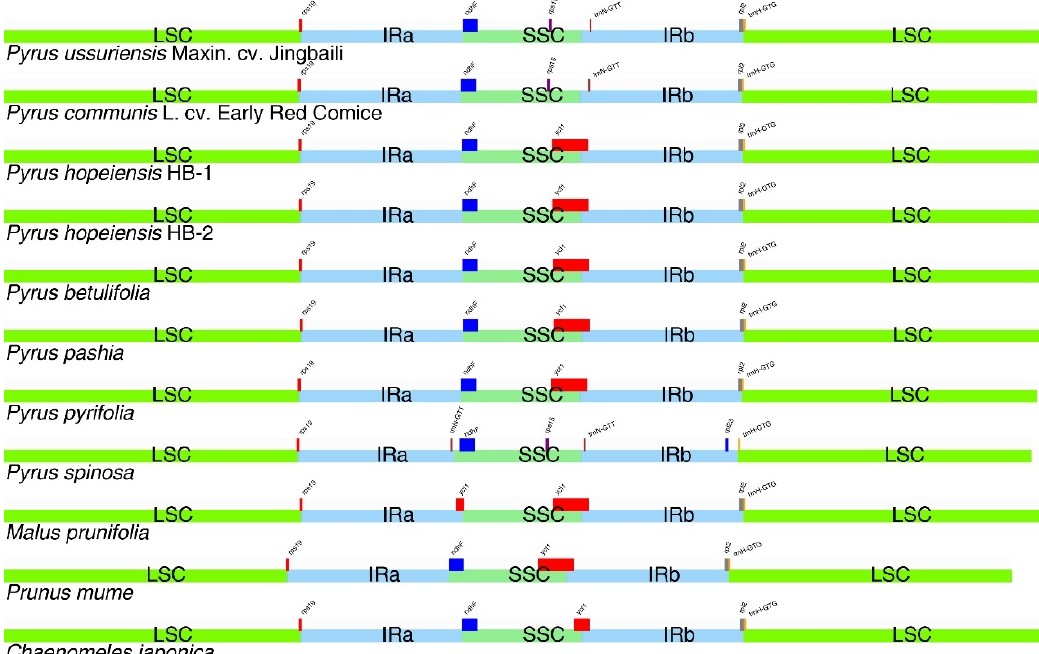
Figure 6. IR contraction analysis of Rosaceae.